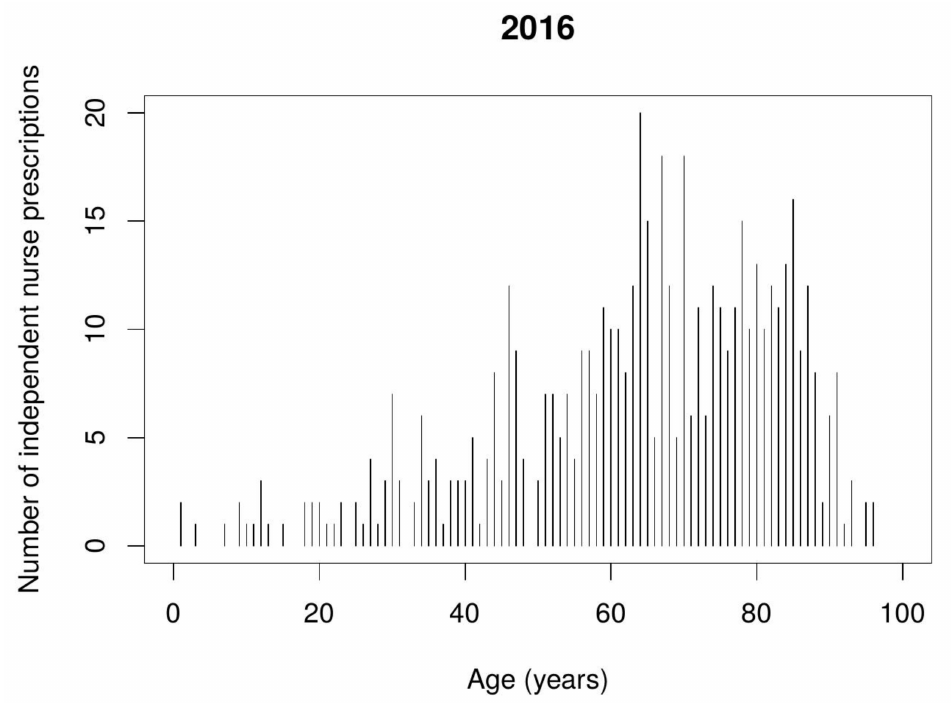
Figure 1. Number of nurse independent prescriptions depending on the patient’s age, during the first year of implementation.